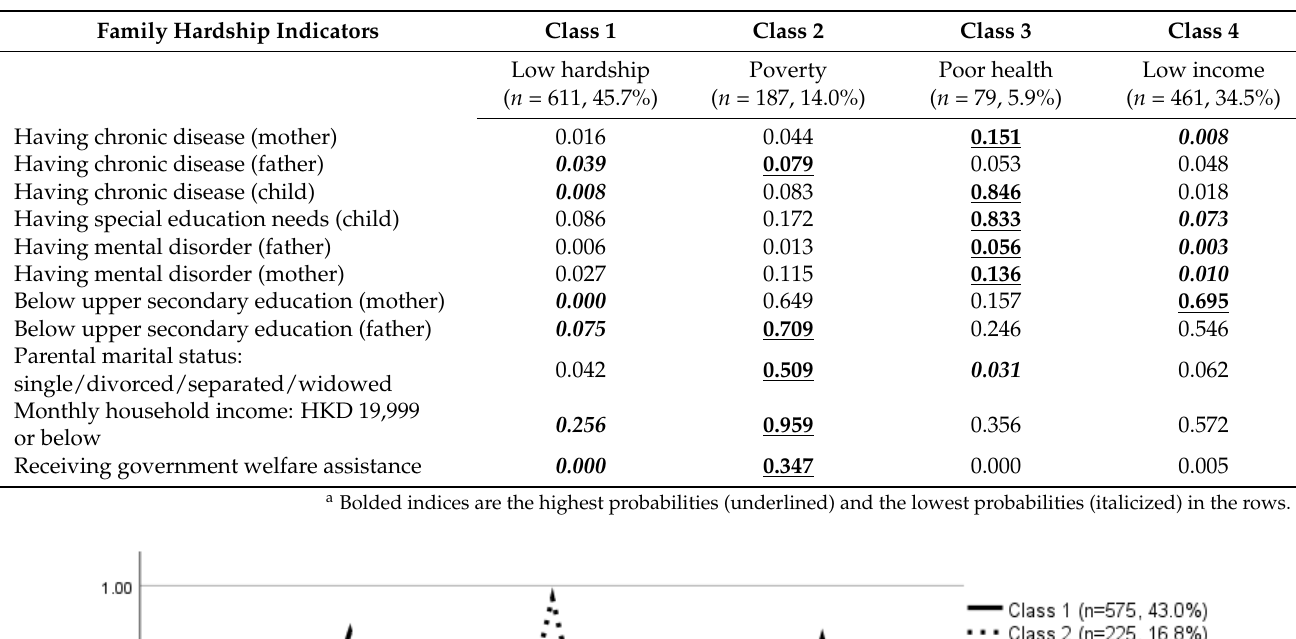
Table 3. Four-class model: estimated probabilities by latent class membership a .